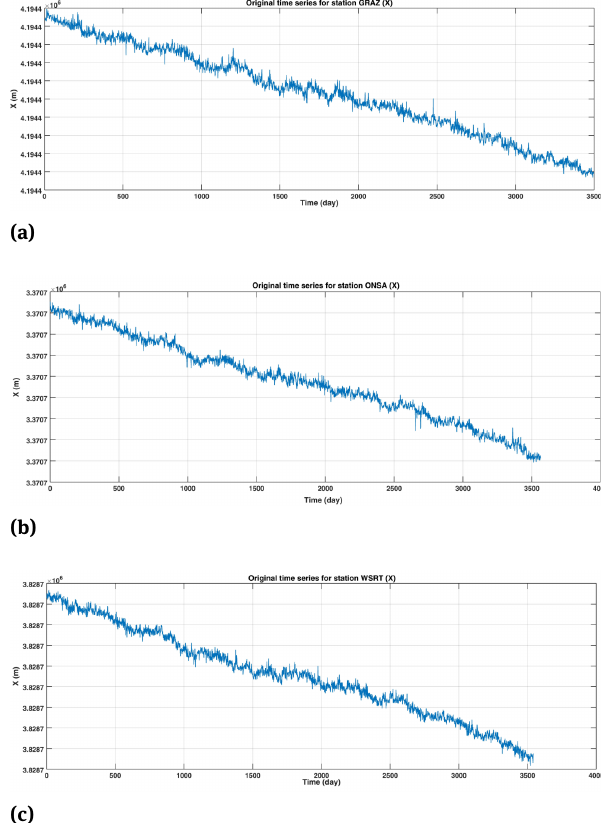
Figure 4: Original time series of parameter X for station (a) GRAZ, (b) ONSA, (c)